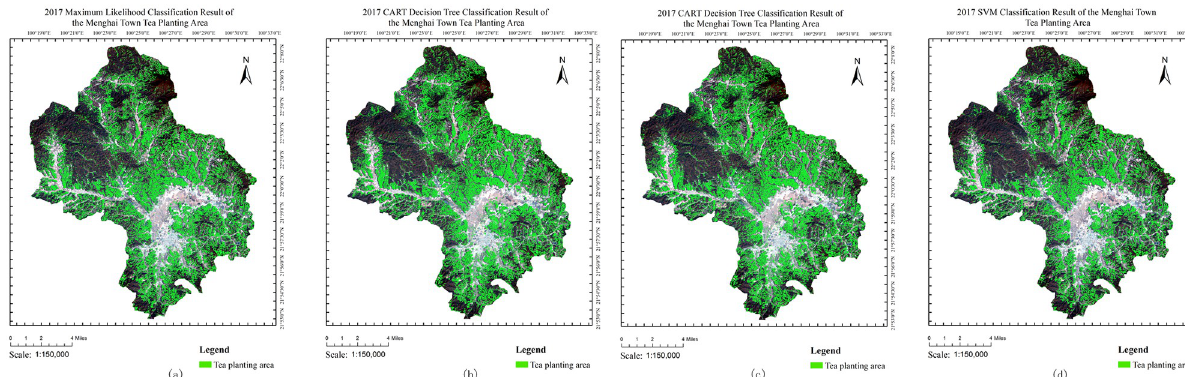
Fig 9. Tea extraction result. The base map of the LandSat8 OLI images with the following composition:R (4),G (3) and B (2). The LandSat8 OLI images were downloaded from USGS National Map Viewer.